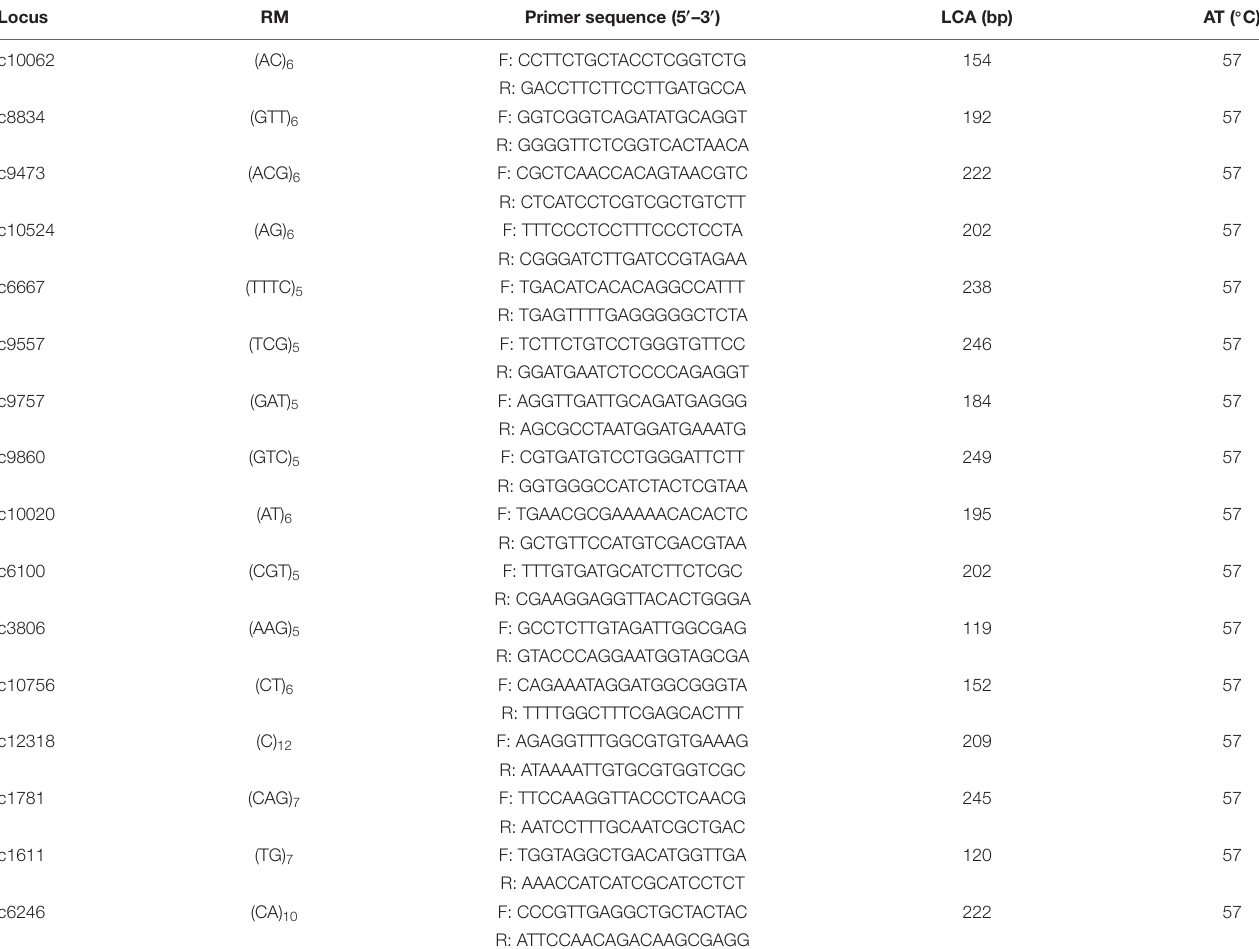
TABLE 1 | Repeat motifs (RM) in the core SSR loci sequences, primer sequences, the length of the cloned alleles (LCA), and annealing temperatures (AT) in the sixteen microsatellite loci developed from transcriptomic library of Alternaria tenuissima.